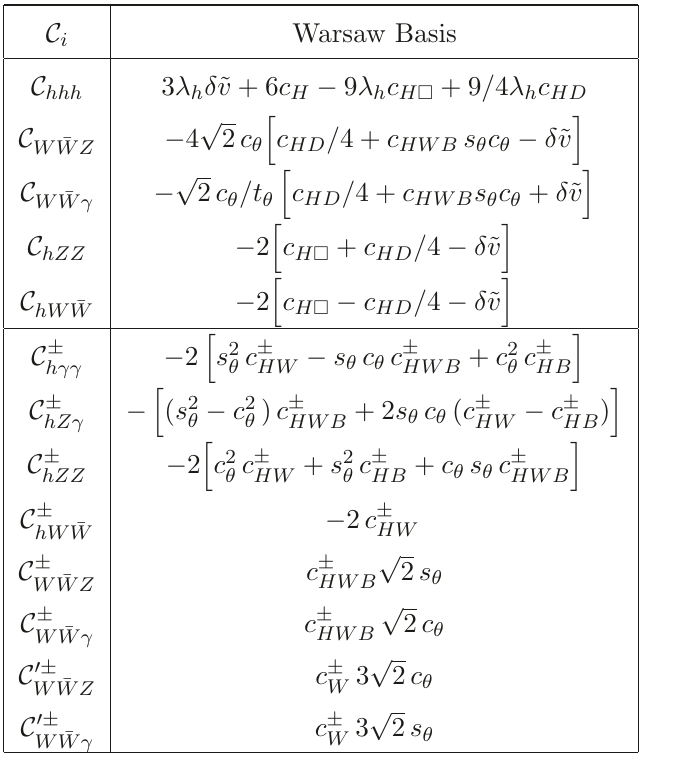
Table 4 . Map between the dimensionless functions Warsaw basis, where we define δ ˜ v